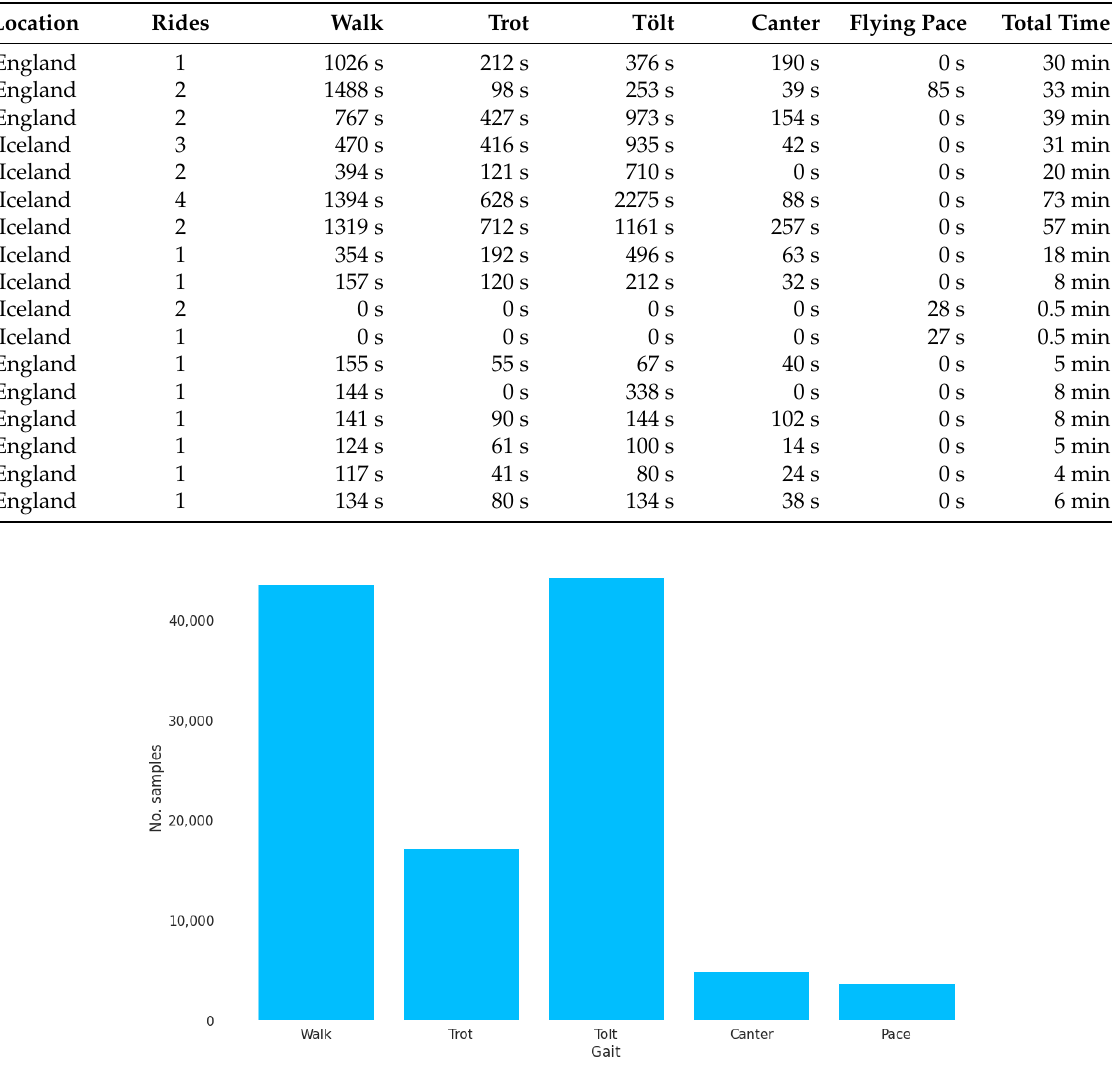
Figure 6. The distribution of horse gaits in the dataset for 1.5 s segments. The training set was split into a training and validation with an 85/15 split, and the samples were shuffled for training. The leave-one-outtest set contained rides from Horse Nos. 1, 2, 8, 9, and 11 while the rest were used for training. Rides from Subject No.